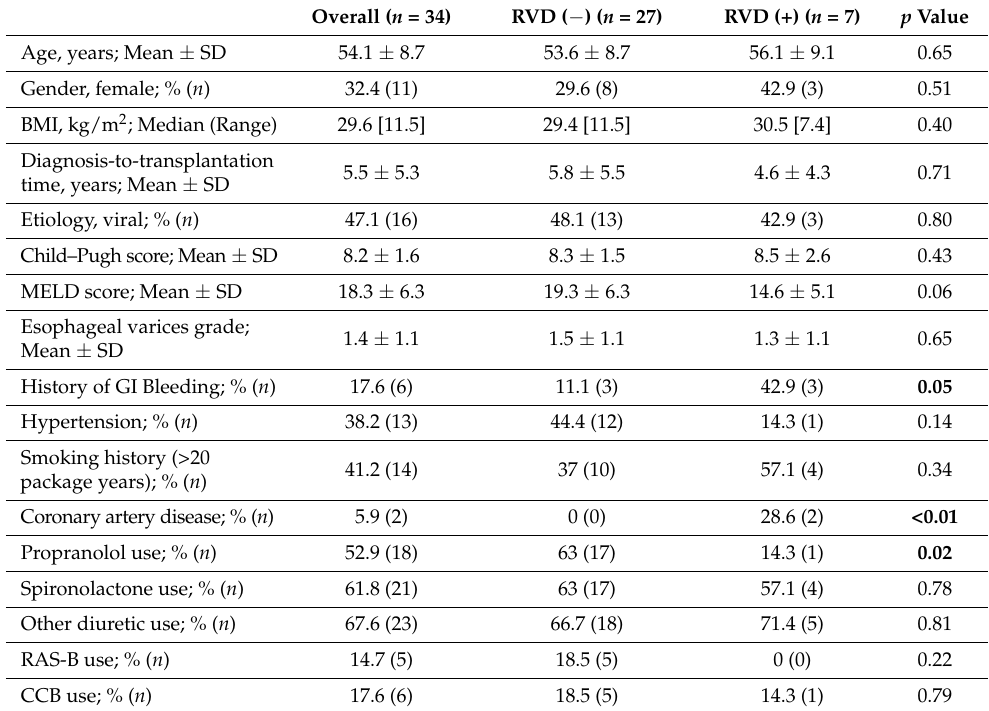
Table 1. Baseline characteristics of the liver transplant recipients.